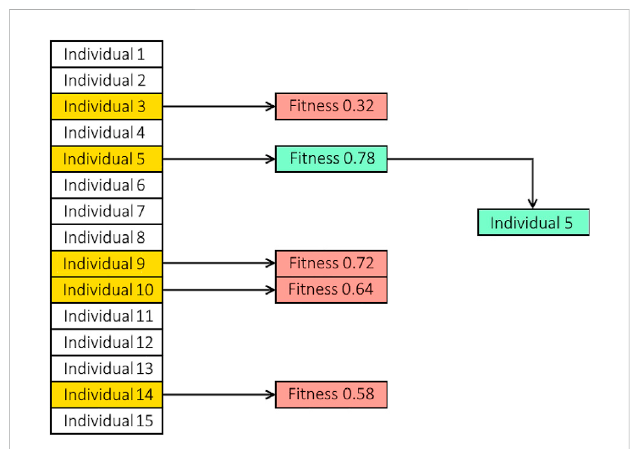
FIGURE 5 A population containing 15 individuals where tournament selection isapplied.Atrandom, fi veindividualsarerandomlychosentocompetein the tournament. The winner of the tournament is based on the